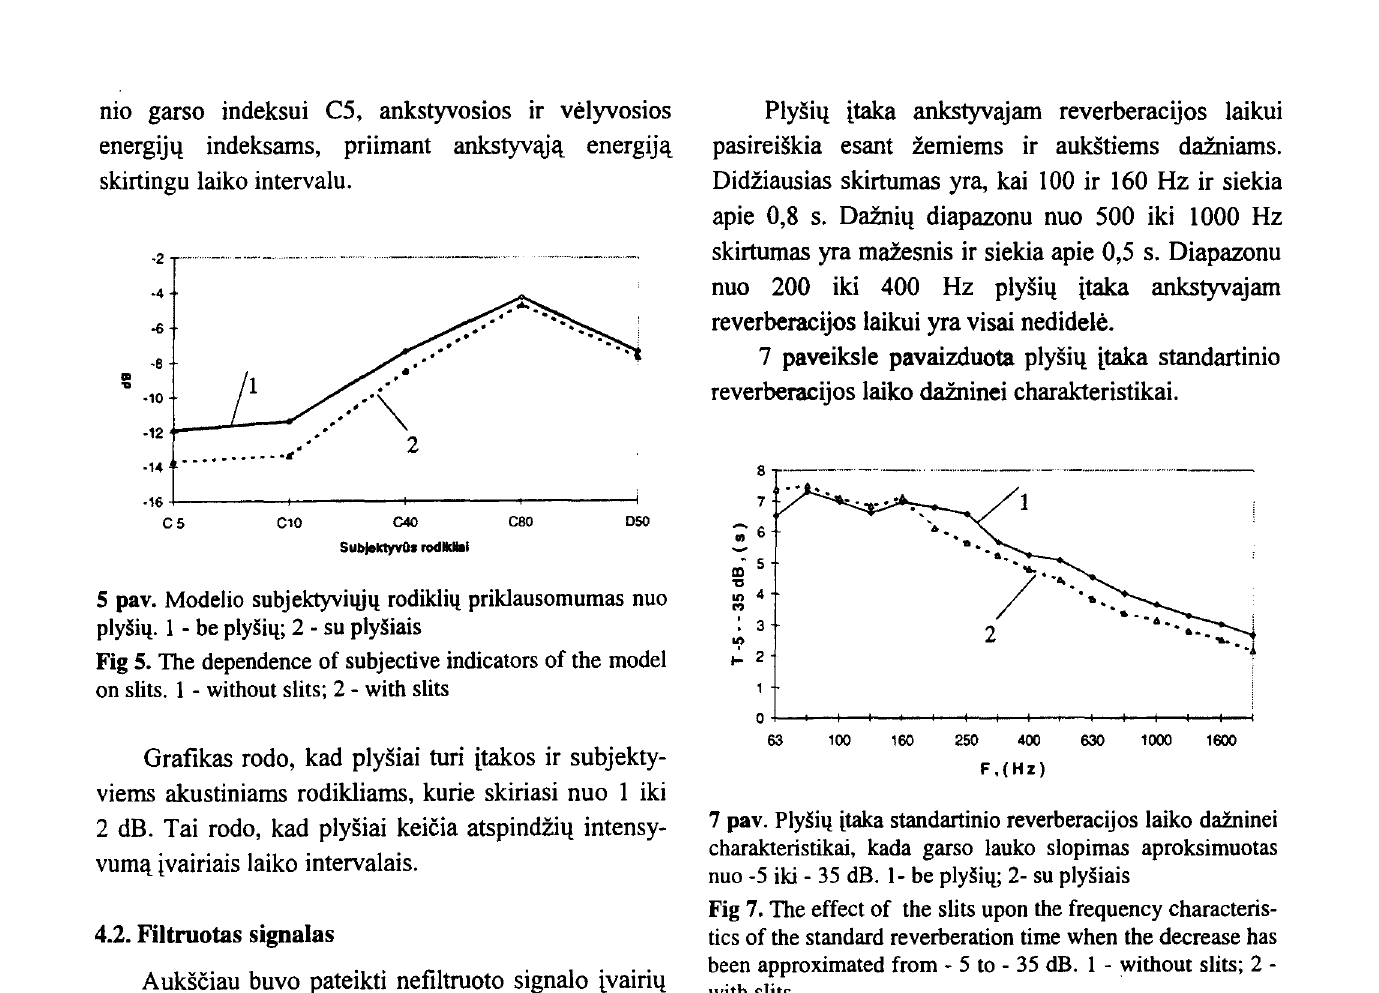
Fig 7. The effect of the slits upon the frequency characteris tics of the standard reverberation time when the decrease has been approximated from - 5 to - 35 dB. 1 - without slits; 2 - with slits Siuo atveju, lyginant su ankstyvuoju reverberaci jos laiku, plysiq itaka yra maZa - iki 160 Hz. Nuo 200 Hz iki 2000 Hz plysiai standartini reverberacijos laik&. sumaiina apie 0,4 - 0,6 s.